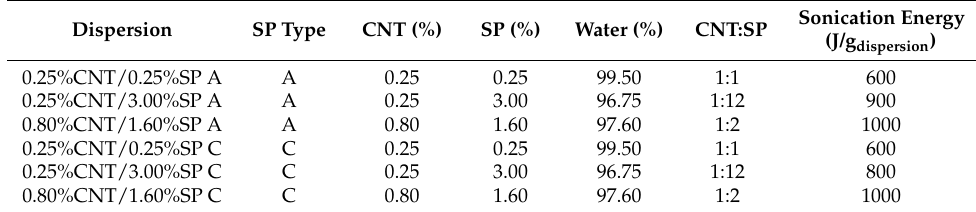
Figure 7. ( a ) UV–Vis absorbance spectra and ( b ) ζ -potential values obtained from different CNT–SP variations using SPs A and C. Table 5. CNT–SP proportions and total sonication energy for SP A and C refinements.